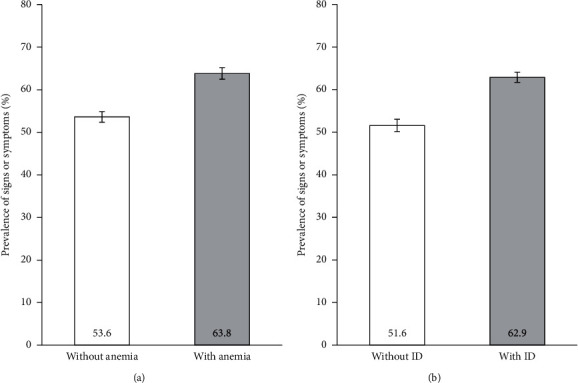
Prevalence of the presence of signs or symptoms of anemia or iron deficiency in (a) participants without anemia (n = 6120) or with anemia (n = 4910) and (b) participants without iron deficiency (n = 4619) or with iron deficiency (n = 6411). Error bars indicate 95% confidence intervals. ID, iron deficiency.